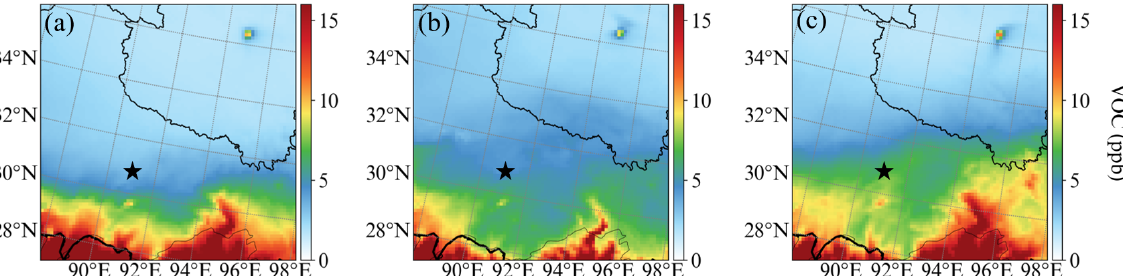
Figure 4. Model spatial distribution of VOC during (a) non-event days, (b) NPF-pre days and (c) NPF-monsoon days. The star is the Nam Co